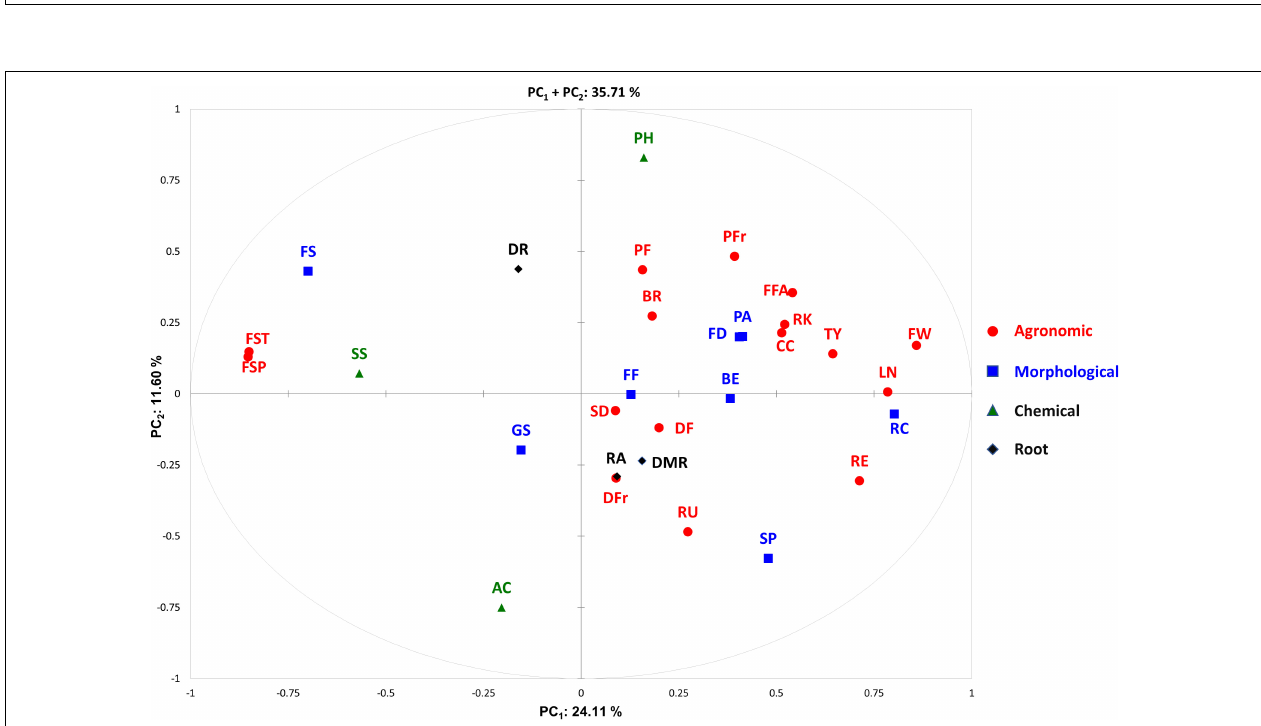
FIGURE 6 | Distribution of the traits scored on the PCA biplot. The direction and distance from the center of the biplot indicate how each OTU contributes to the first two components. The different category of traits is indicated using different color codes. Trait acronyms are listed in Table 2 .